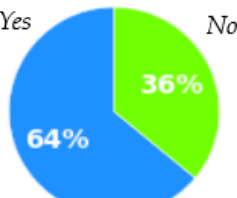
Figure 14. Answers for question of is it necessary to add new projects to current IFRS standards for holdings of cryptocurrencies?